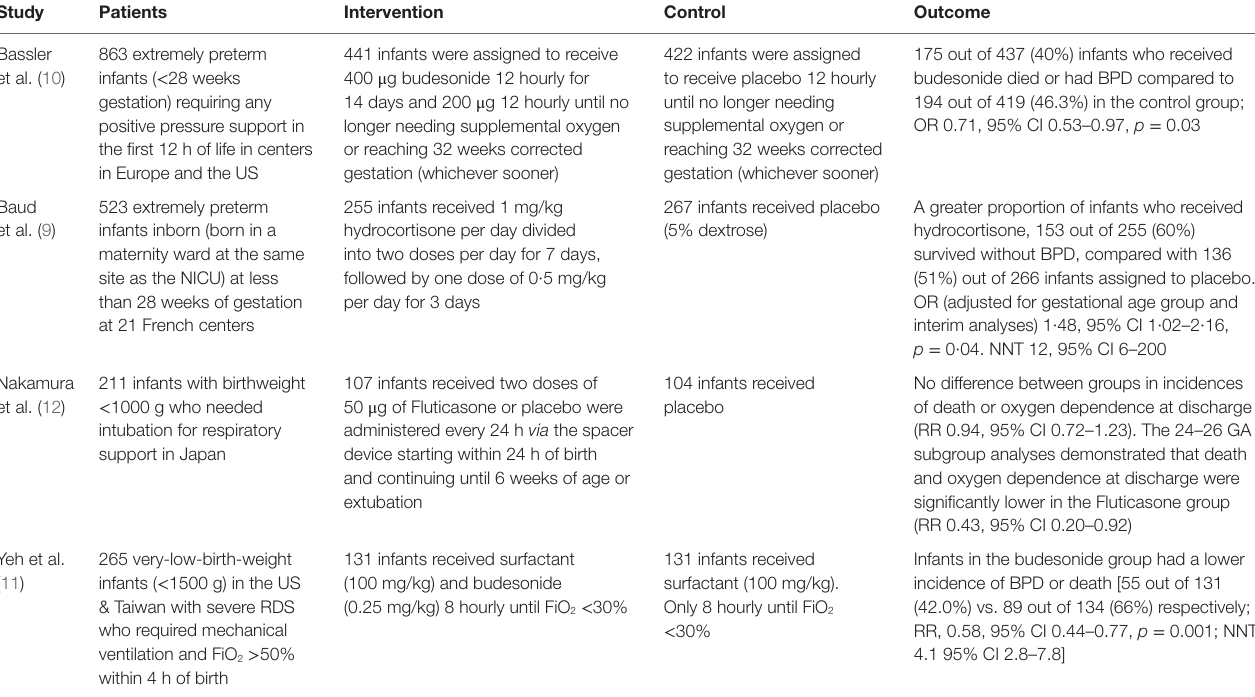
TABLE 1 | Trials of alternative route or dose of corticosteroids in BpD.